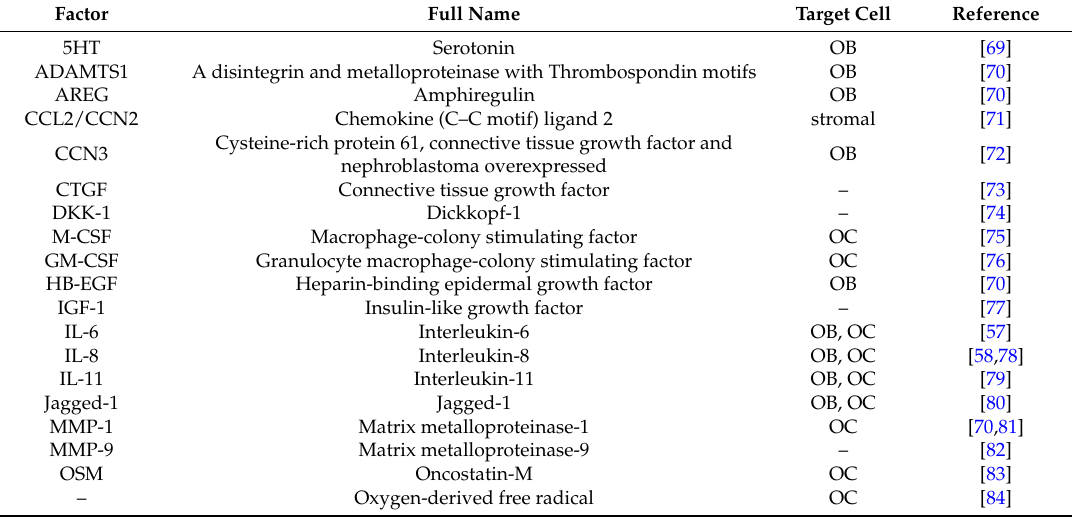
Table 1. Breast cancer-secreted factors that induce differentiated osteoclasts indirectly or directly. Factors may act on osteoblasts to indirectly induce osteoclast differentiation or directly on